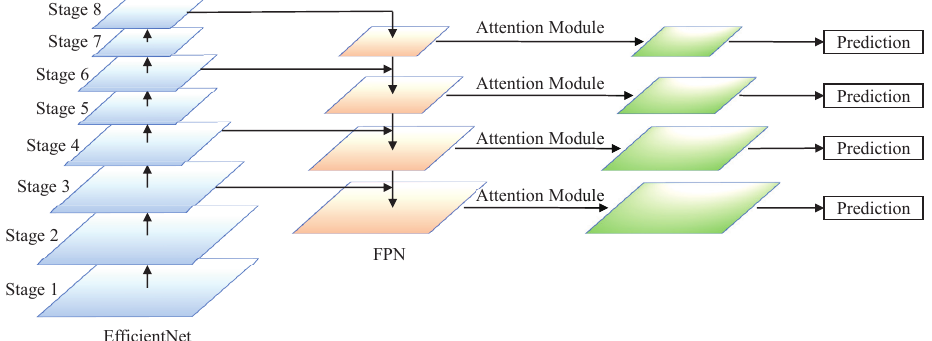
Figure 3. The network structure of the proposed